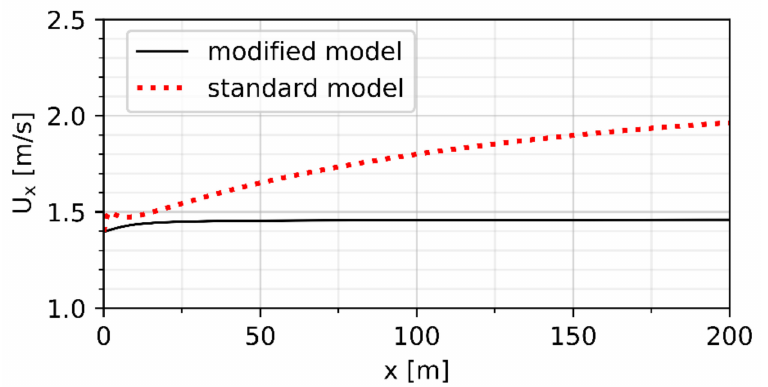
Figure 1. Development of the boundary layer for the standard model and the model